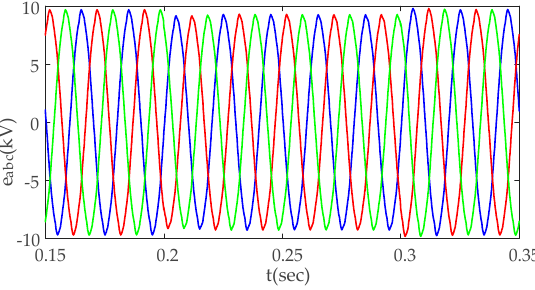
Figure 14. Three-phase voltage curves on the grid side at the moment of disturbance.